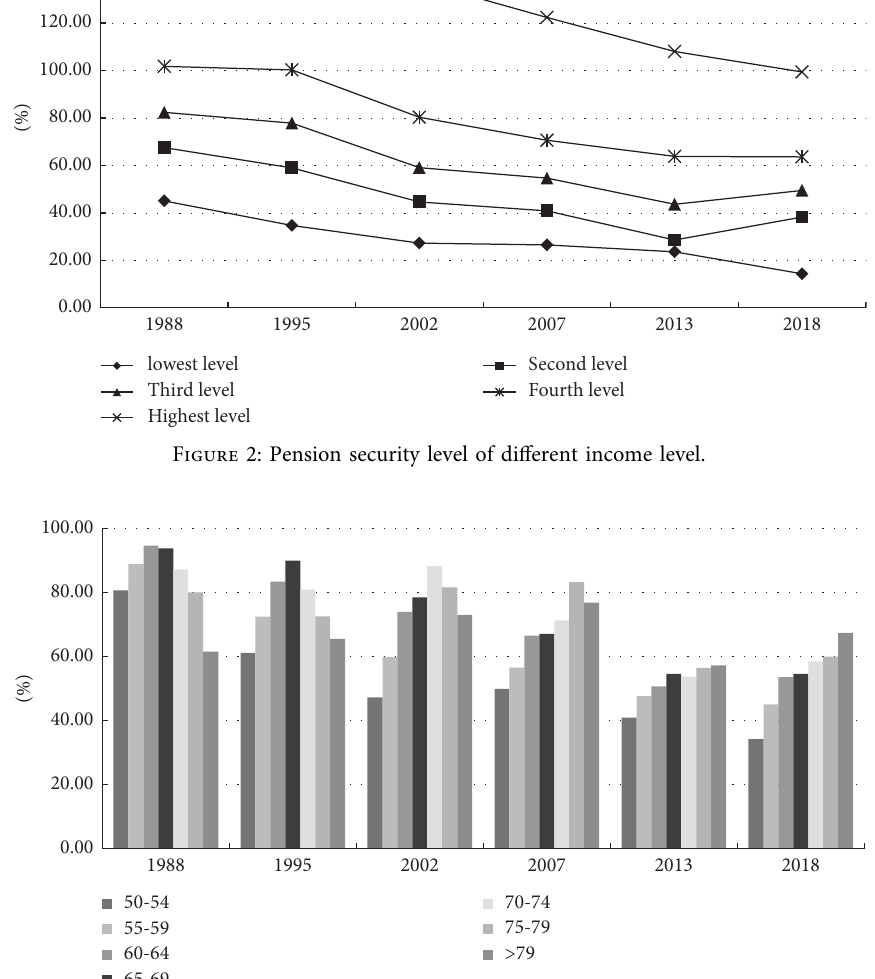
Figure 3: Pension security level of different age groups.